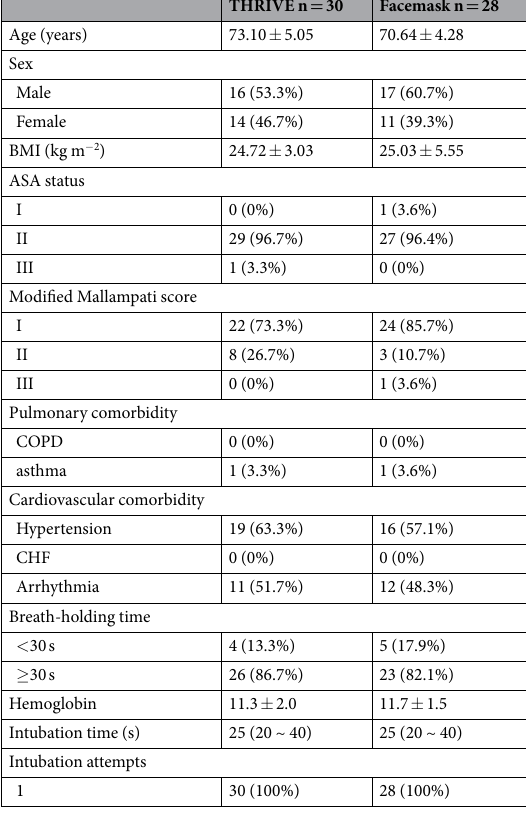
Table 1. Patient Characteristics. Data are presented as mean (SD), number (proportion) or median (inter- quartile range). Abbreviations: THRIVE, transnasal humidified rapid insufflation ventilator exchange; COPD, chronic obstructive pulmonary disease; CHF, chronic heart failure.